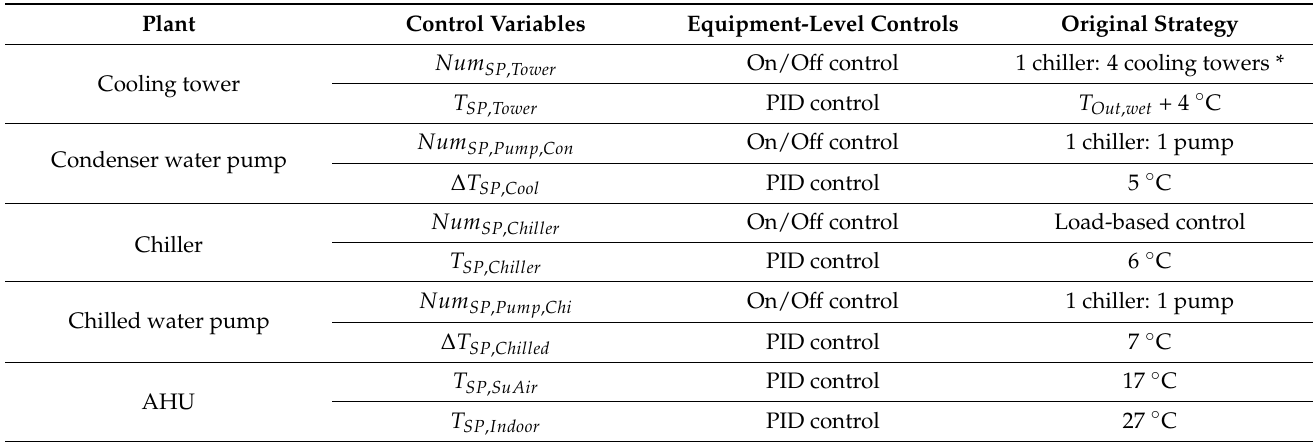
Table 2. Control scheme for each